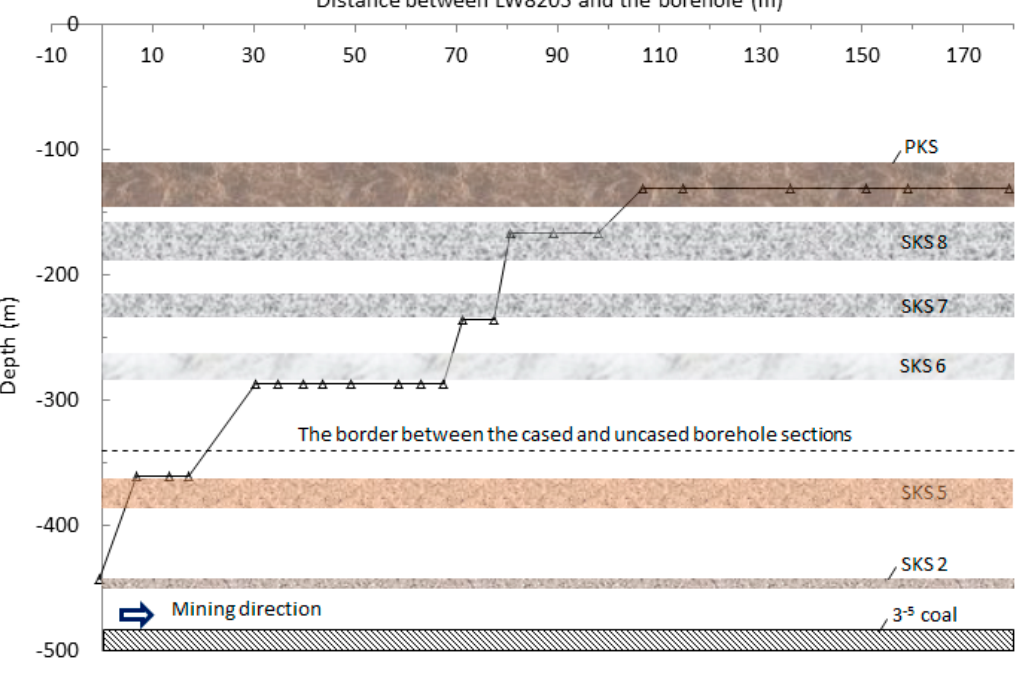
Figure 6. The relationship between the dislocation or blockage of the surface borehole and the advance of the working face.